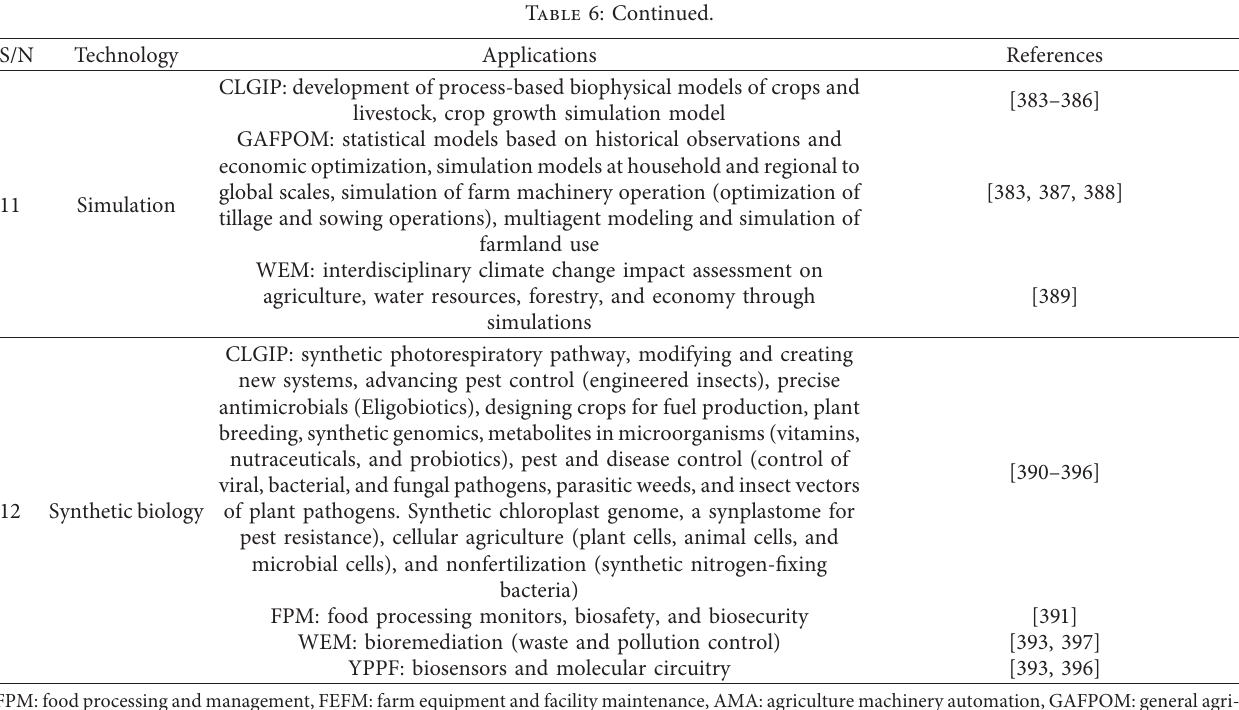
quantified as shown in Table 9. The result depicts that convergence of the disruptive technologies was the highest in both DDPPPT and MERT with 13.5% followed by TMR and monitoring with 12% (Figure 9). The technology con- vergence in DDPPPT, for example, includes synthetic bi- ology, robotics, IoT, drones, cloud computing, blockchain,